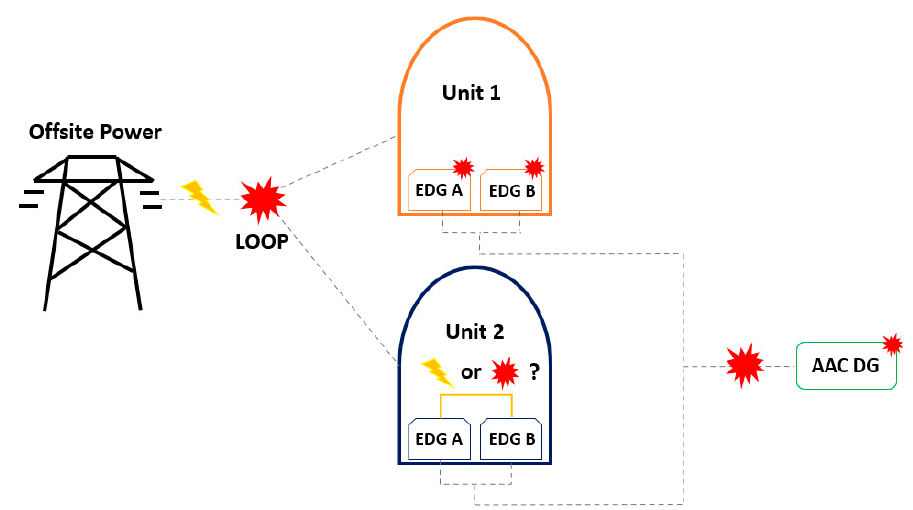
Figure 8. An accident in which even the AAC DG fails in an SBO situation.